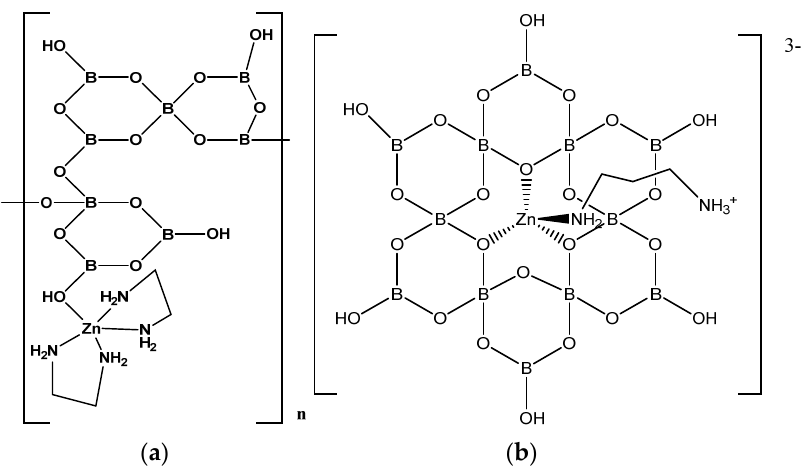
Figure 10. ( a ) The repeating unit of [Zn(en) 2 {B 8 O 11 (OH) 4 }] n ( 47 ), and ( b ) a drawing of the [(Hdap)Zn{B 12 O 18 (OH) 6 }] 3- anion in (H 2 dap) 3 [(Hdap)Zn{B 12 O 18 (OH) 6 }] 2. 14H 2 O ( 51 ). [Zn 2 (dap)(dap’){B 8 O 13 (OH) 2 }] n ( 48 ) [30] has a similar structure to 37 and 38 with the 18-electron Zn (II) centers tetrahedral with 2 monodentate bridging dap N -donor ligands.